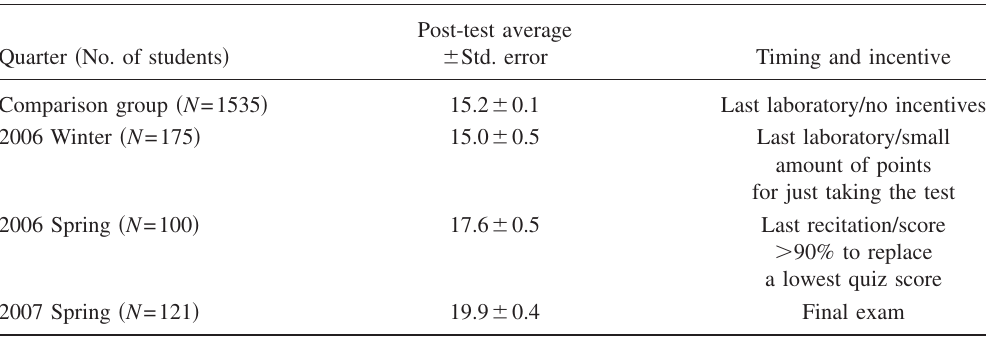
TABLE II. Post-test results and conditions. Post-test average (cid:1) Std. error